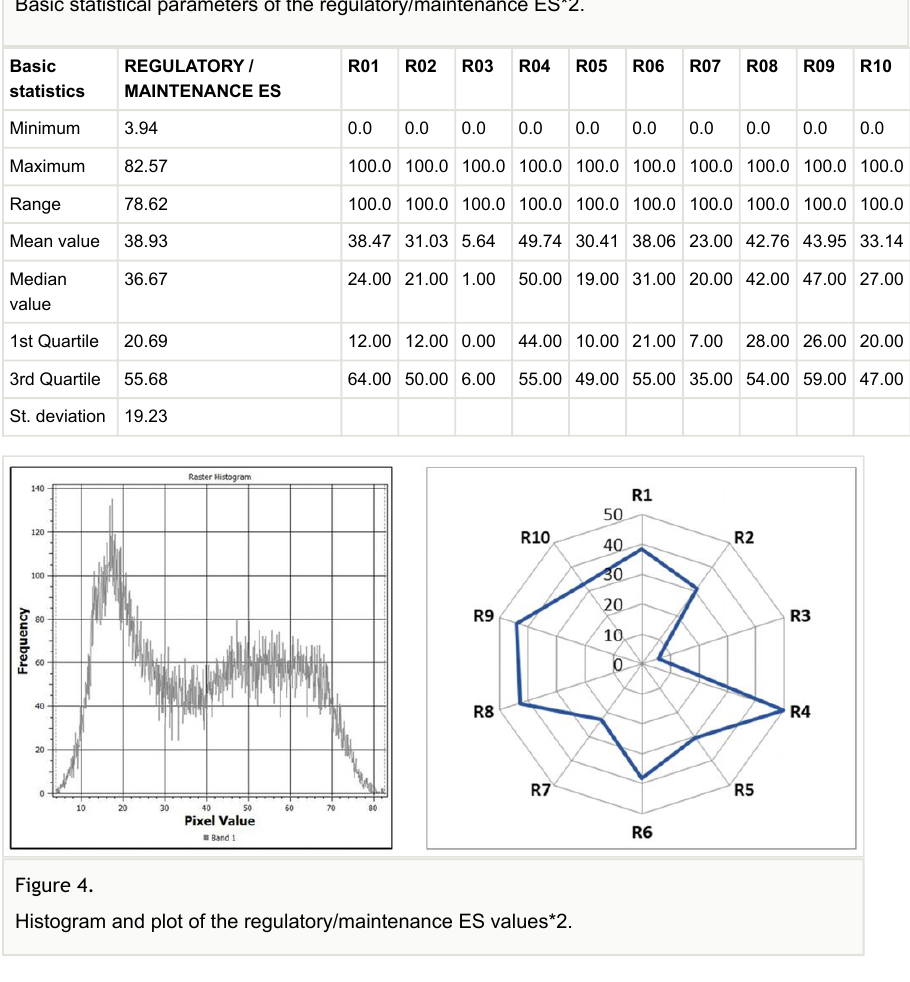
Table 4. Basic statistical parameters of the regulatory/maintenance ES*2.